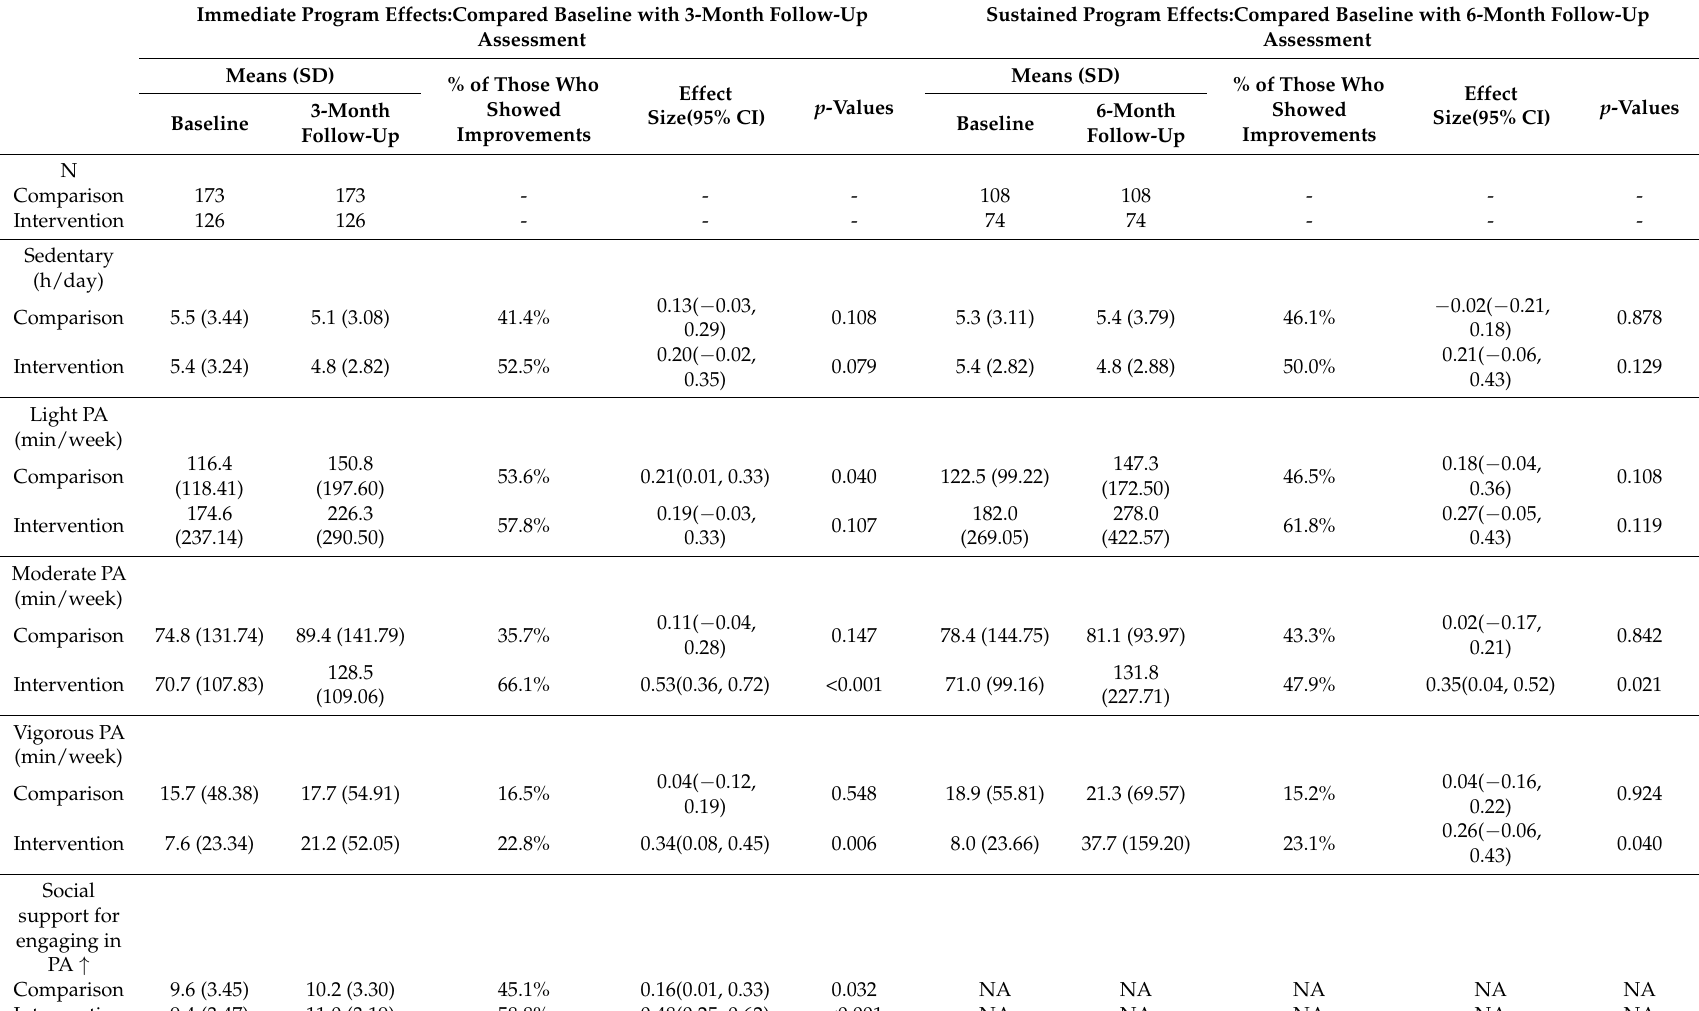
Table 2. Unadjusted immediate and sustained program effects on engagement in physical